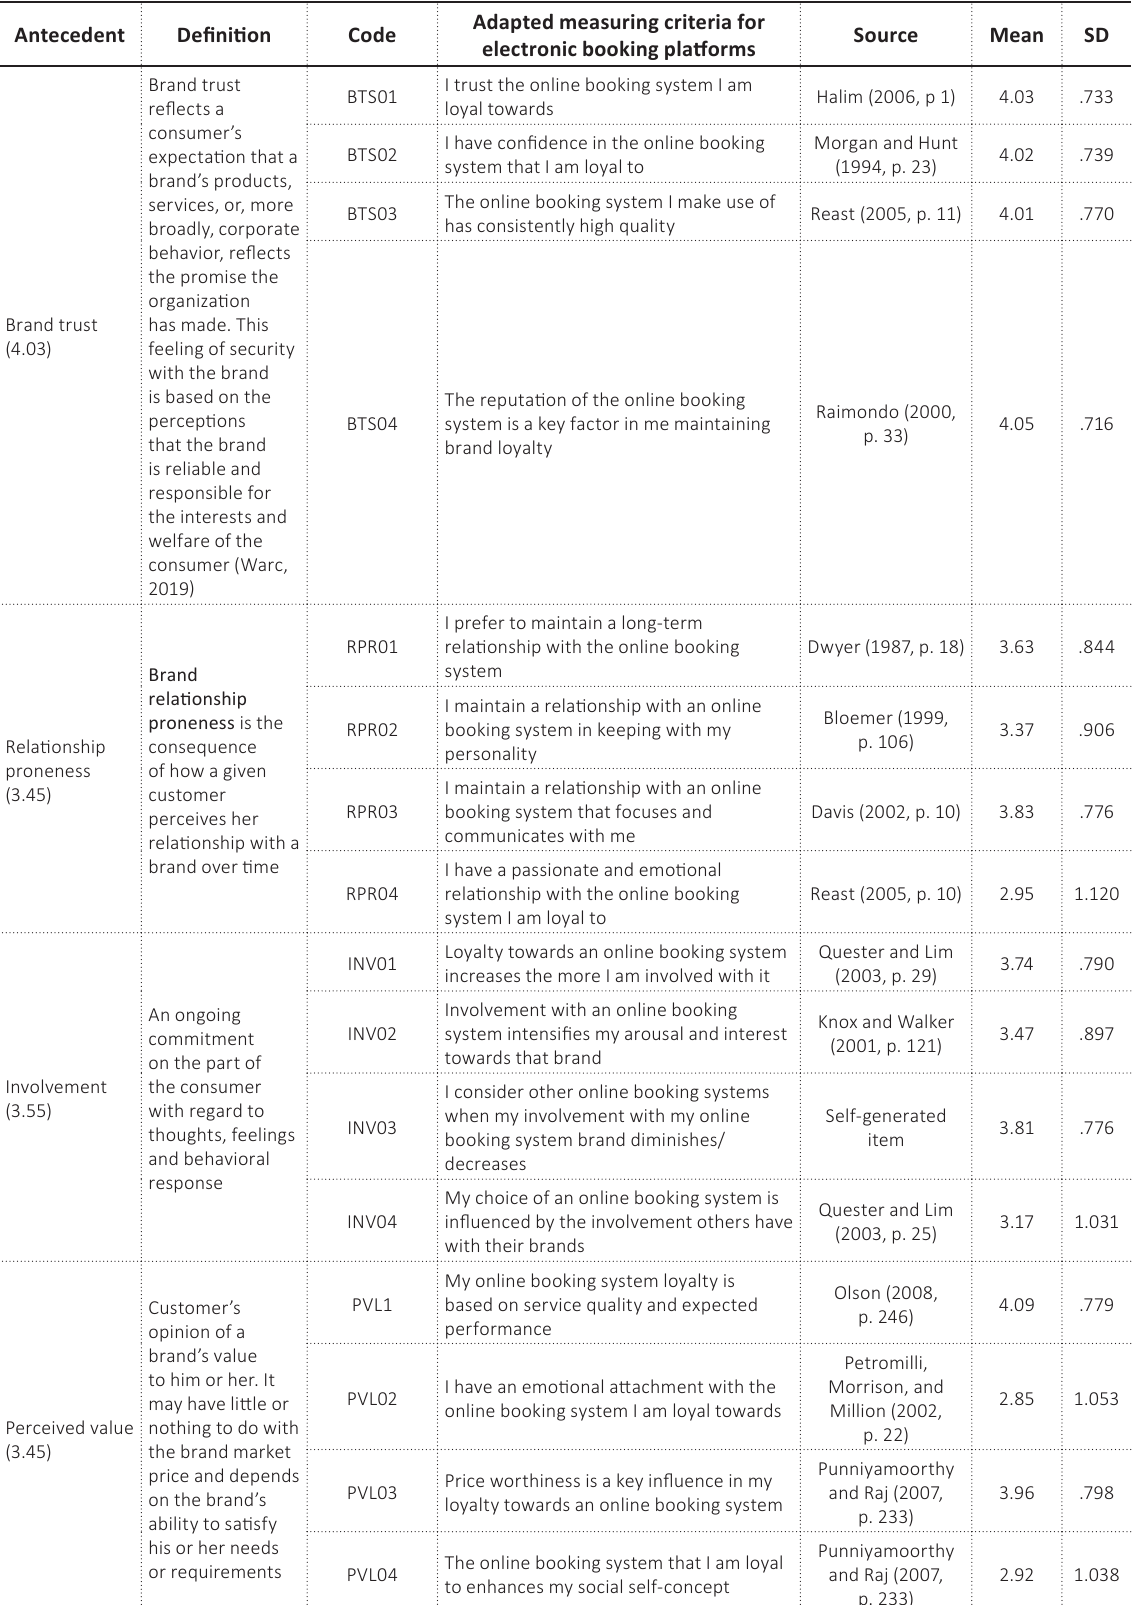
Table 1 (cont.). Descriptive statistics and the origins of the questionnaire